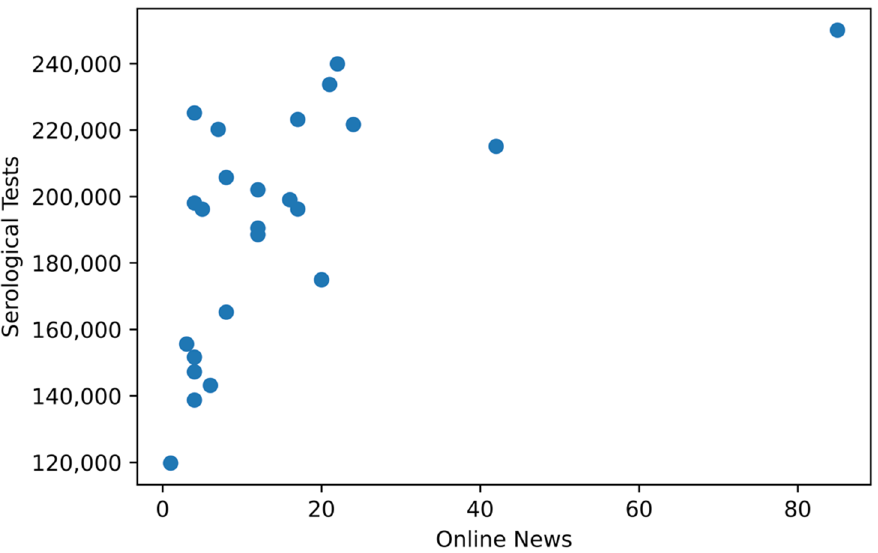
Figure 5. Scatterplot of news and testing data showing the monotonic shape of the relationship be- tween news and testing data. between news and testing